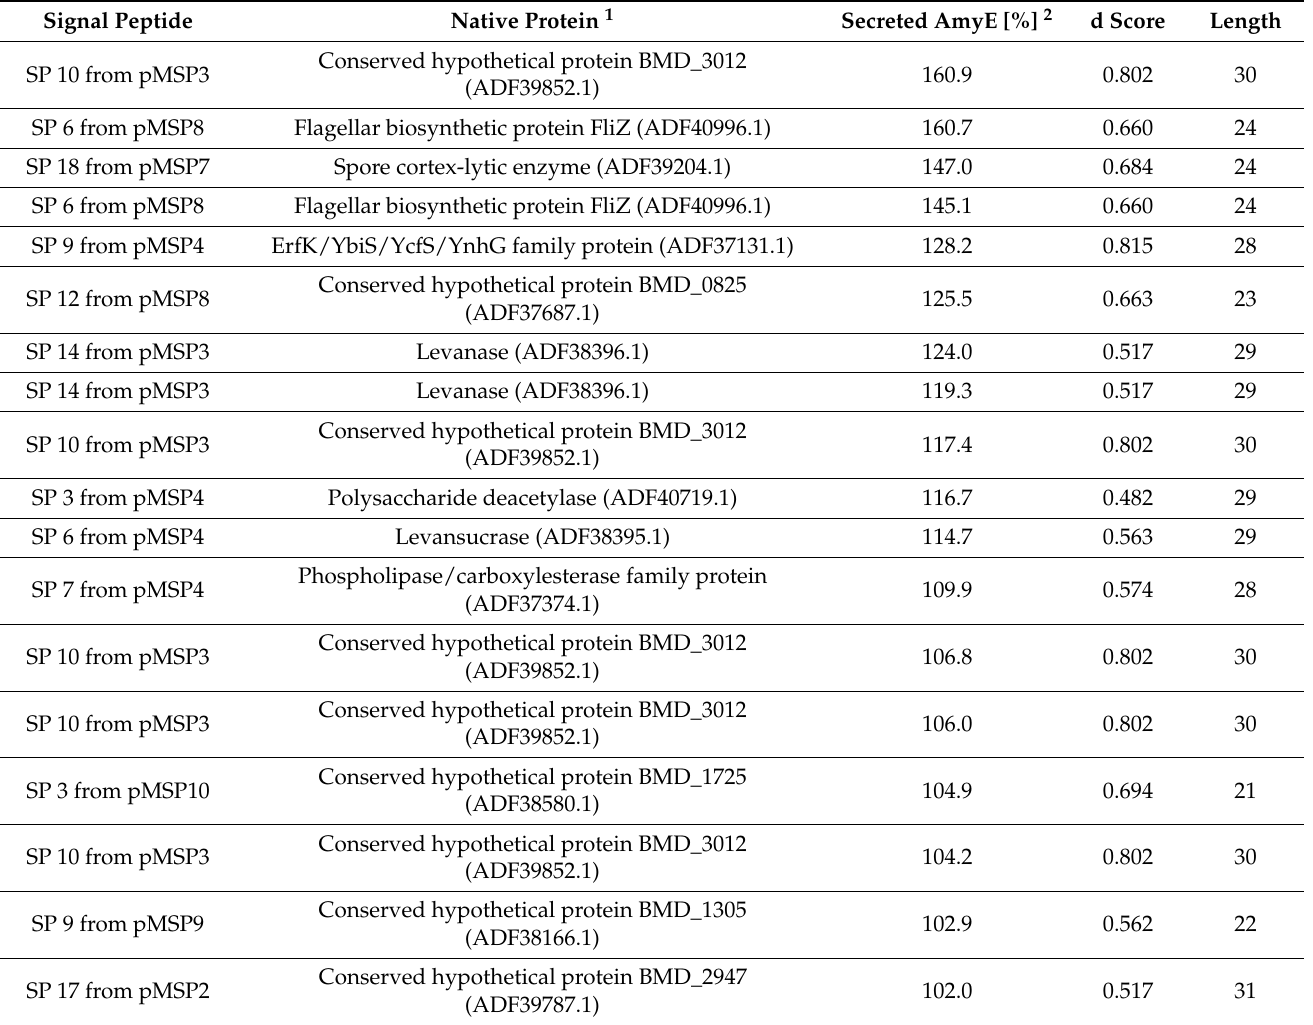
Table 1. Signal peptides achieving a better secretion of AmyE compared to the SP of the lipase A (100%). Signal